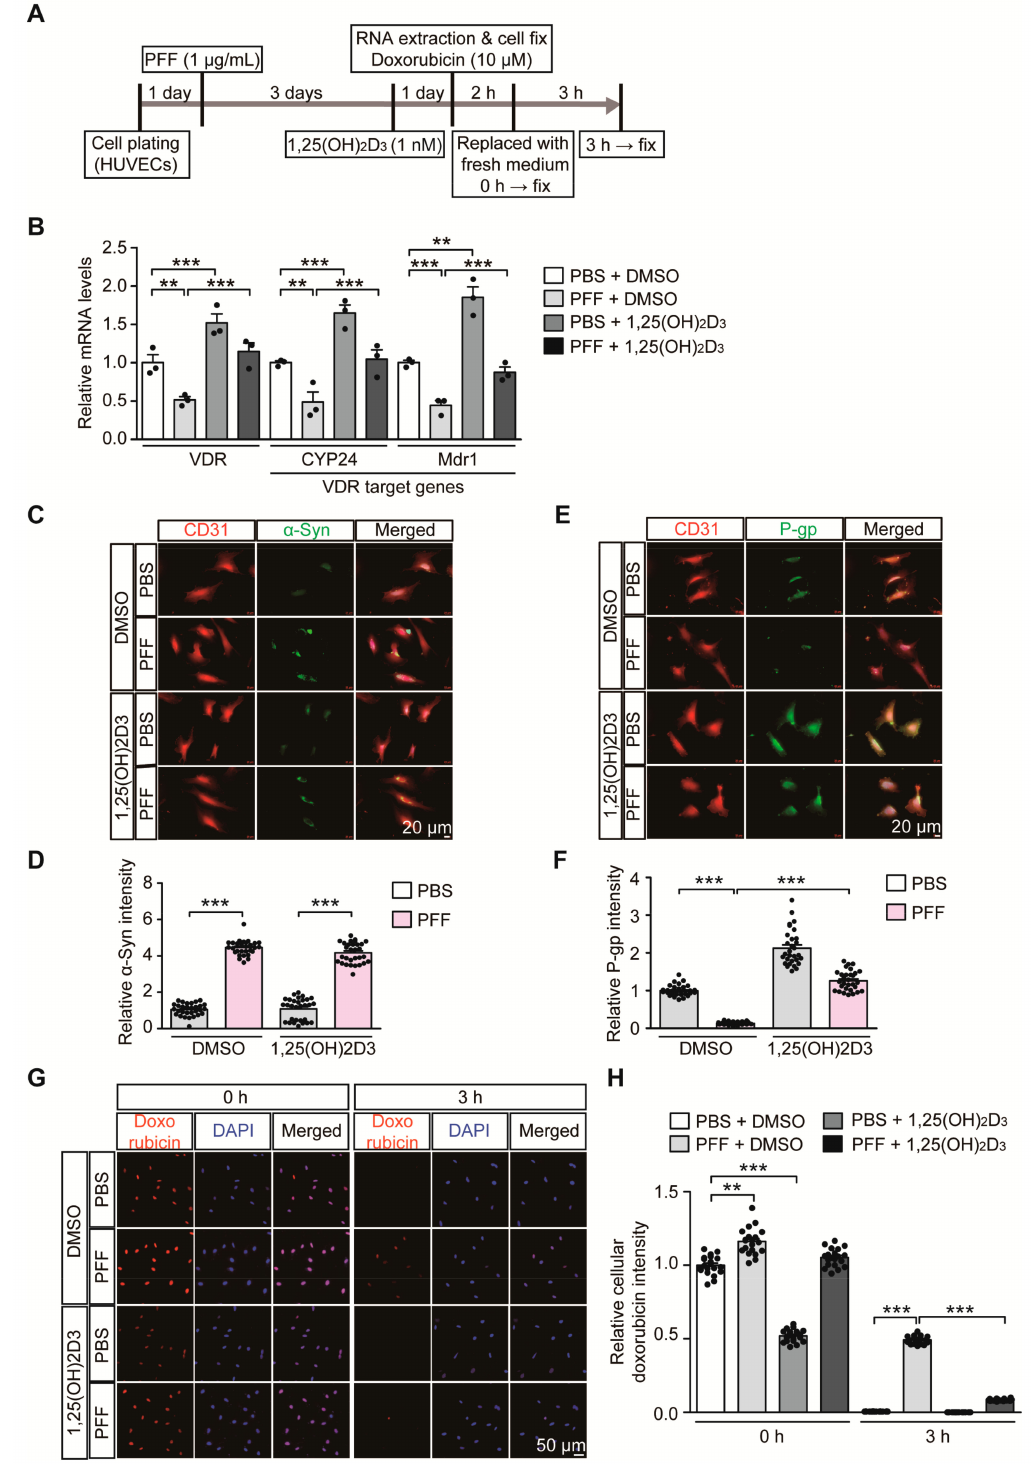
Figure 4. 1,25(OH) 2 D 3 activation of VDR reverses VDR transcriptional downregulation and reduced P-gp expression in HUVECs following PFF treatment. ( A ) Experimental schedule of RTQ-PCR